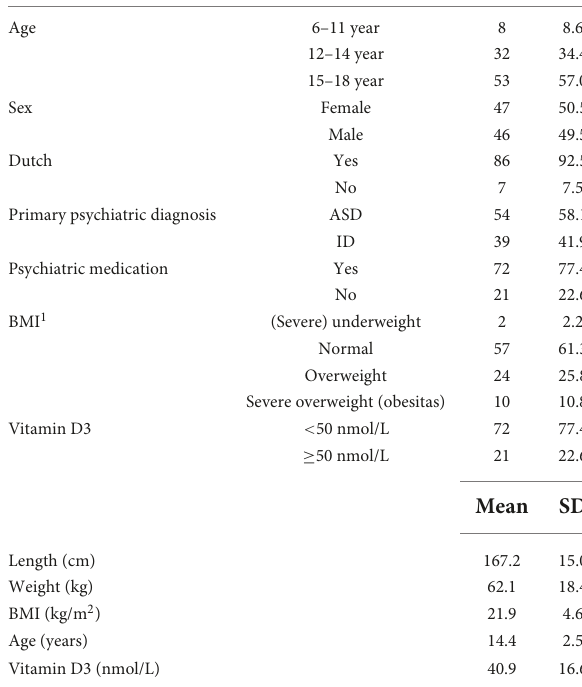
TABLE 1 Descriptive of the study population ( n =